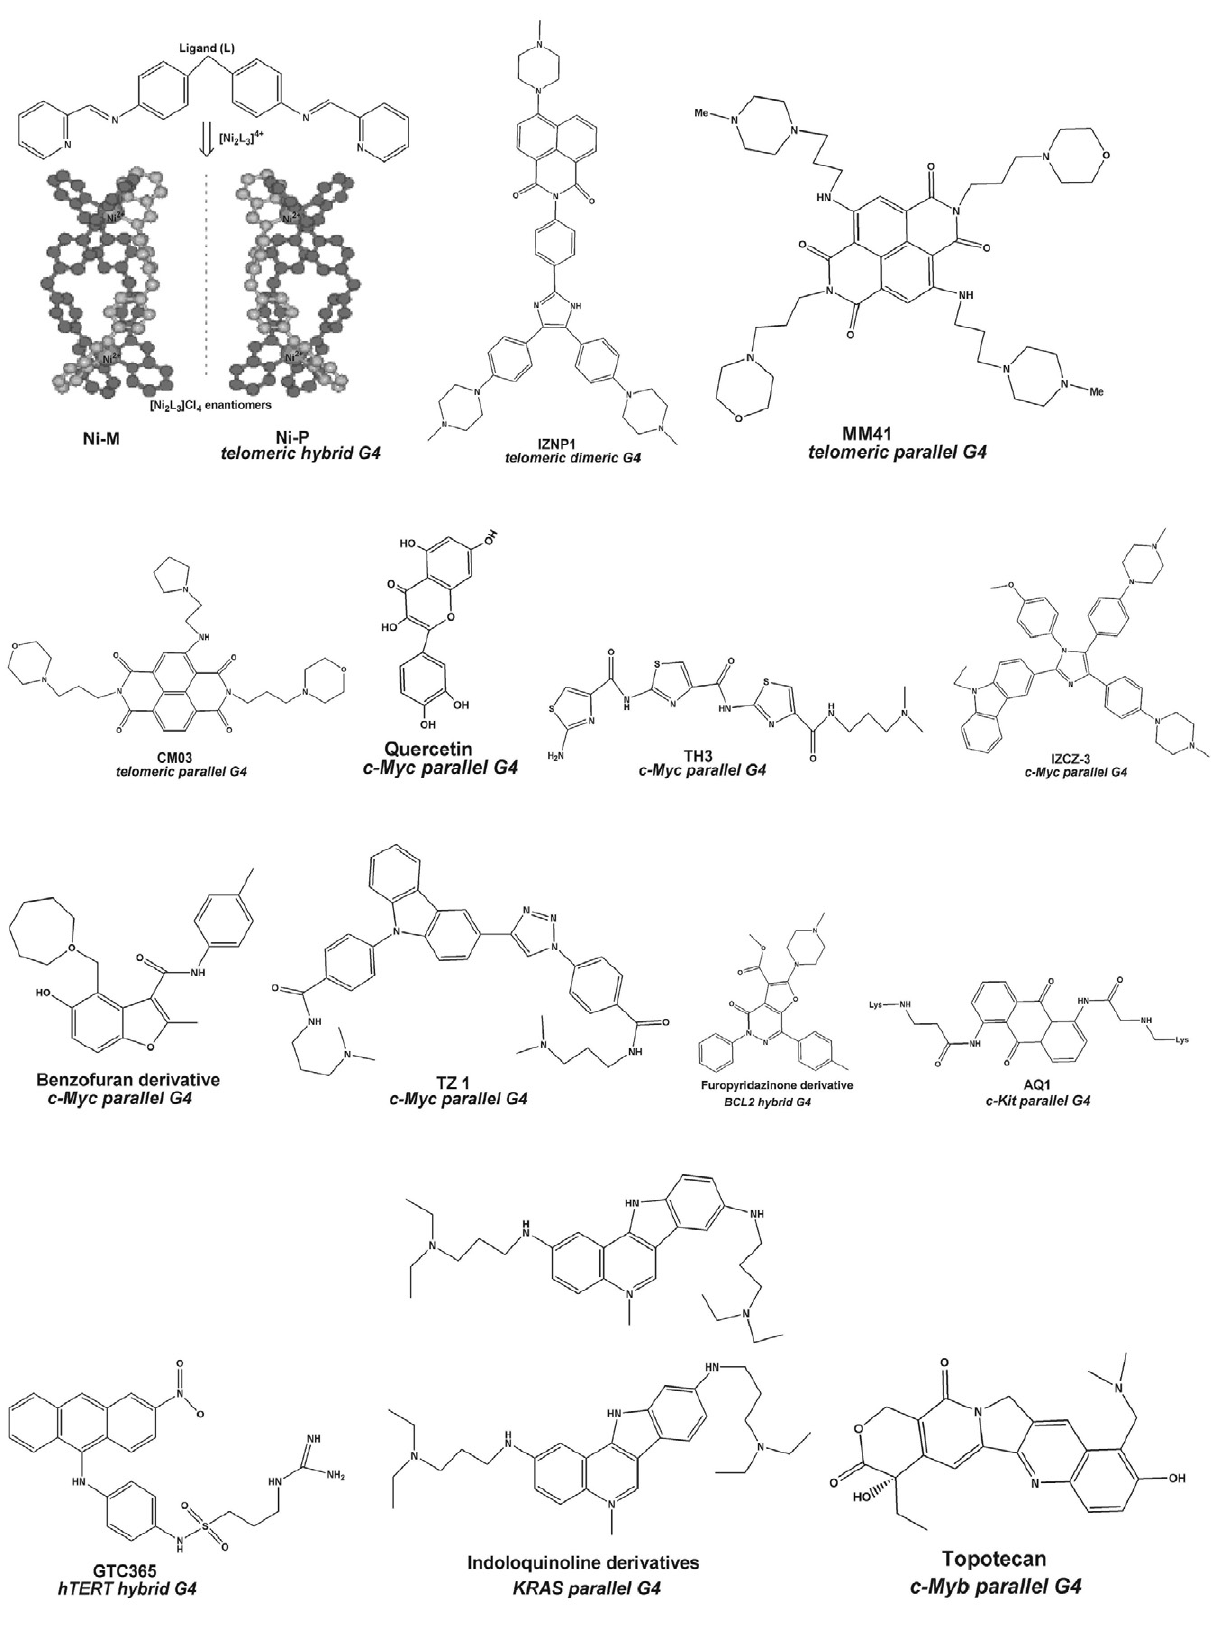
Figure 4. Chemical structures of G4 ligands (with denoted target topologies by italic) that exhibit anti-cancer activities (Table